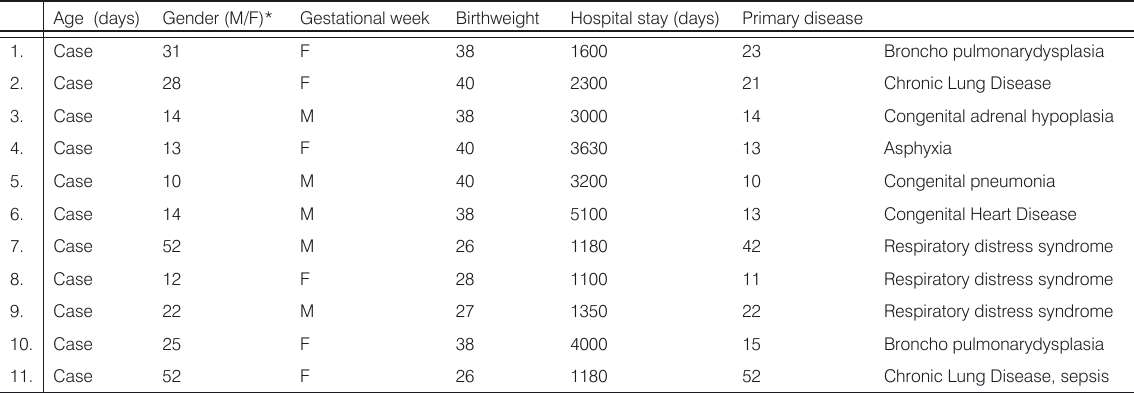
Table 1. Demographic features of the infants colonized with